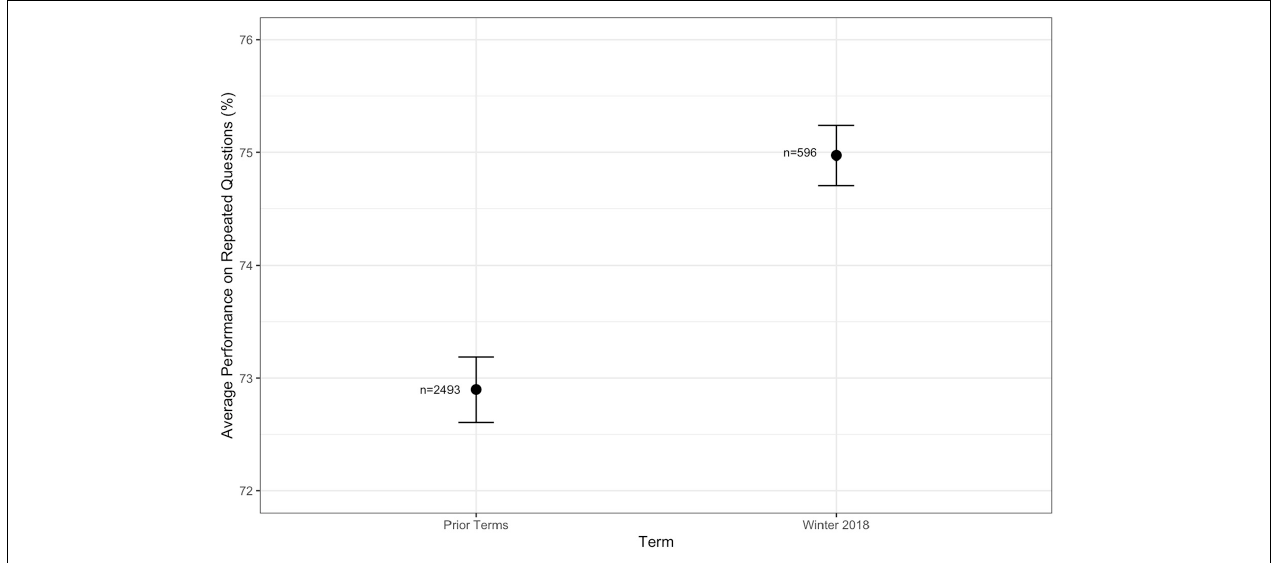
FIGURE 4 | Comparison of overall performance on Repeated Questions for Prior Terms and Winter 2018. Note the overall scale of the y-axis when comparing performance between